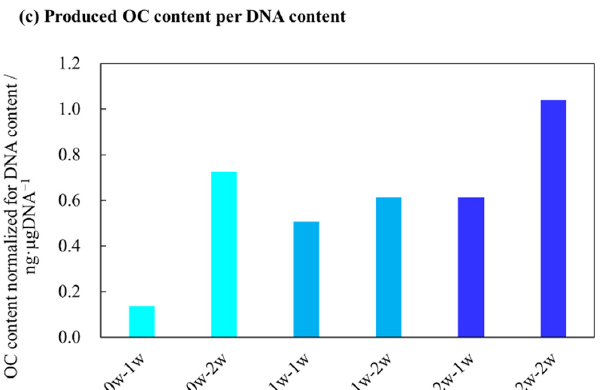
Figure 5. Biological assays of tissue-engineered bones constructed under various cell culture condi- tions. ( a ) Amount of DNA in 1/4 AFS, ( b ) ALP activity normalized for the amount of DNA *, and ( c ) total production amount of OC normalized for the amount of DNA *. *: The DNA amount, ALP activity value, and OC production amount in 1/4 size AFS were multiplied by 4 and calculated as the result of the whole AFS. Therefore, no error bars were added to the normalized graphs. The error bars in Figure 5a are shown as standard deviation (S.D.).